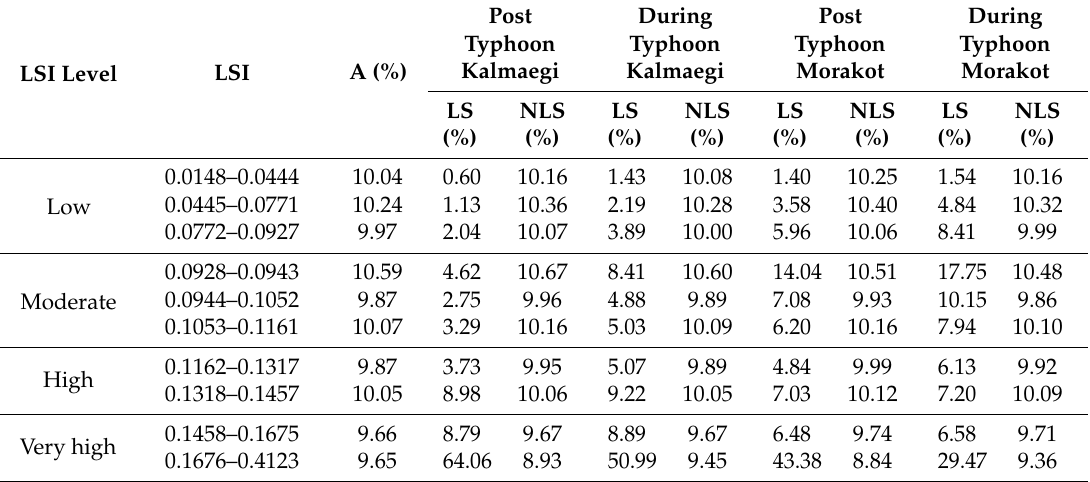
Table 8. Statistics of landslides which occurred in the events (Typhoon Kalmaegi and Typhoon